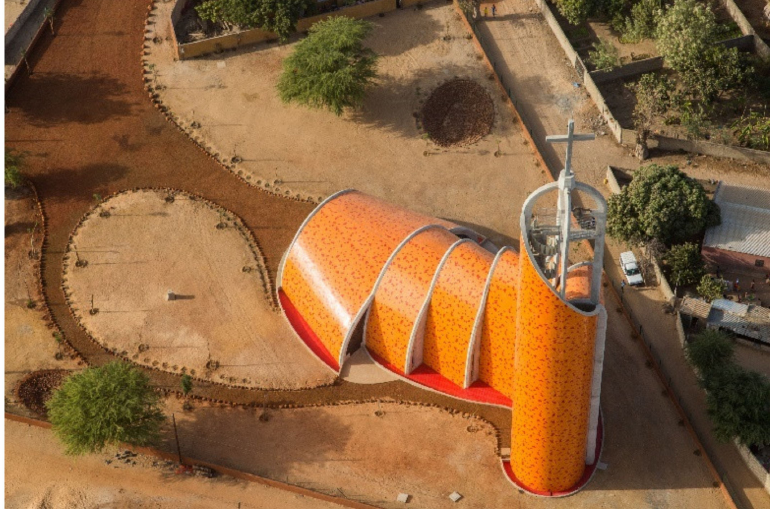
Figure 1. Nianing Church, S é n é gal (© R é gis L’Hostis/IN SITU Architecture).